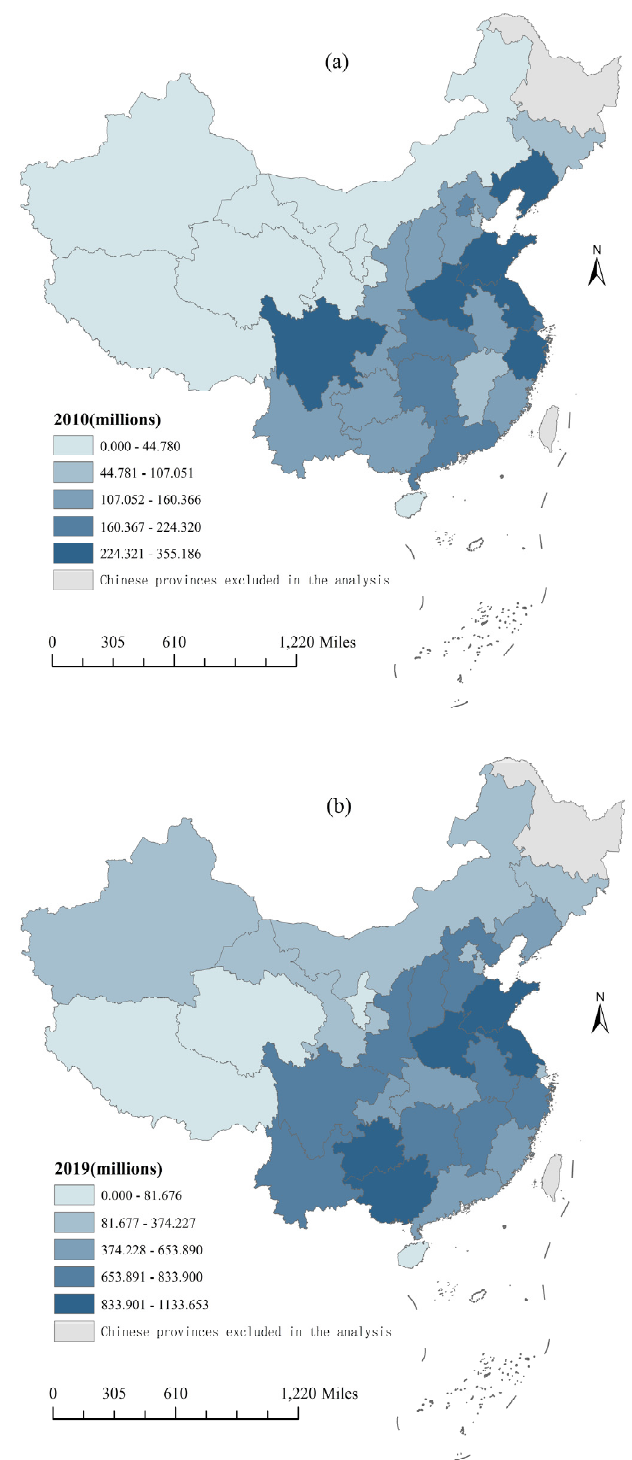
Figure 1. Spatial distribution of domestic tourism demand. Note: Based on the data of domestic tourist arrivals in 2010 ( a ) and 2019 ( b ).